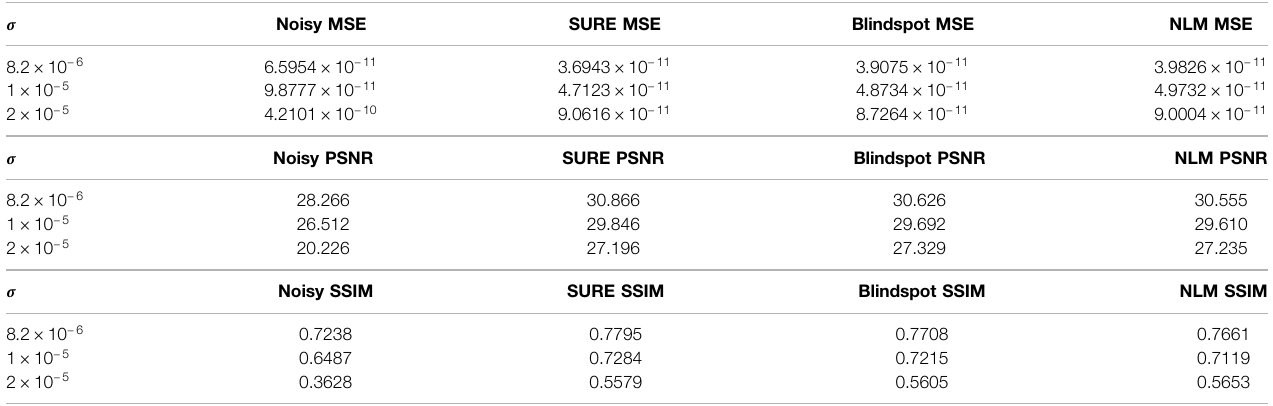
TABLE 1 | Test results knee single-coil dataset.